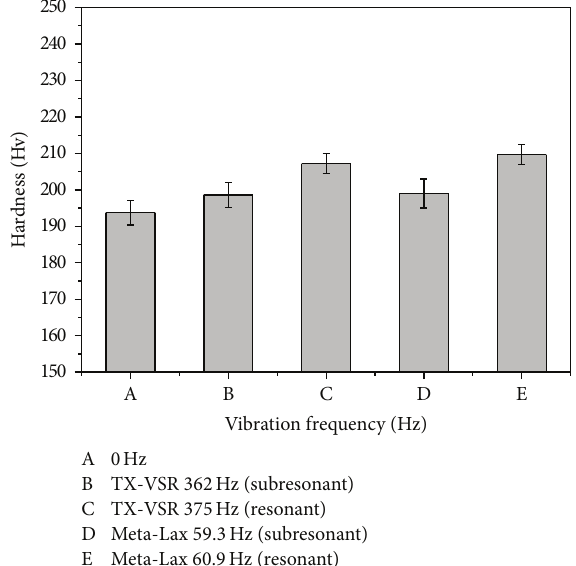
Figure 13: The 𝛿 -ferrite content of two vibration modes.